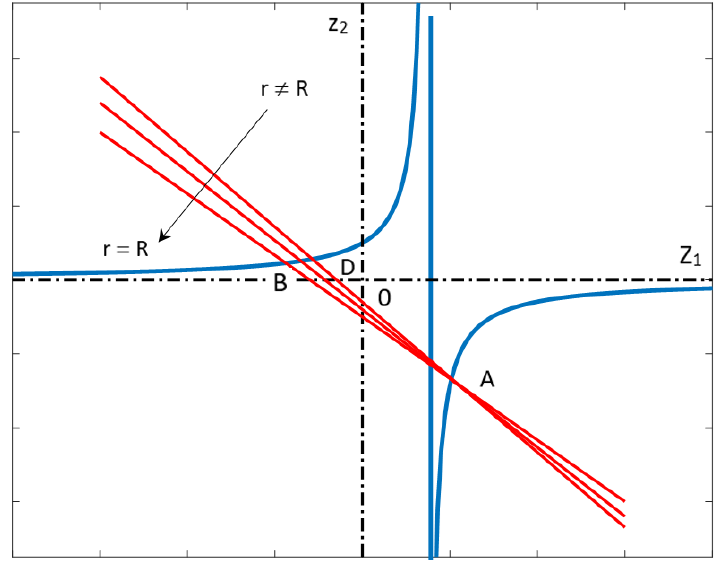
Figure 2. Localization of stability points on the plane z 1 z 2 for system